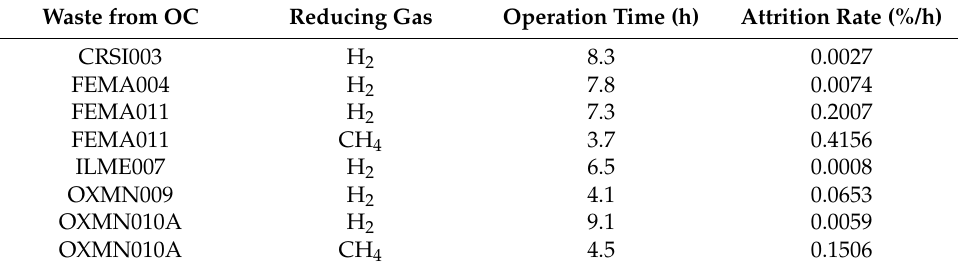
Table 3. Discontinuous batch fluidized bed (bFB) operating times to obtain waste and attrition. Waste from